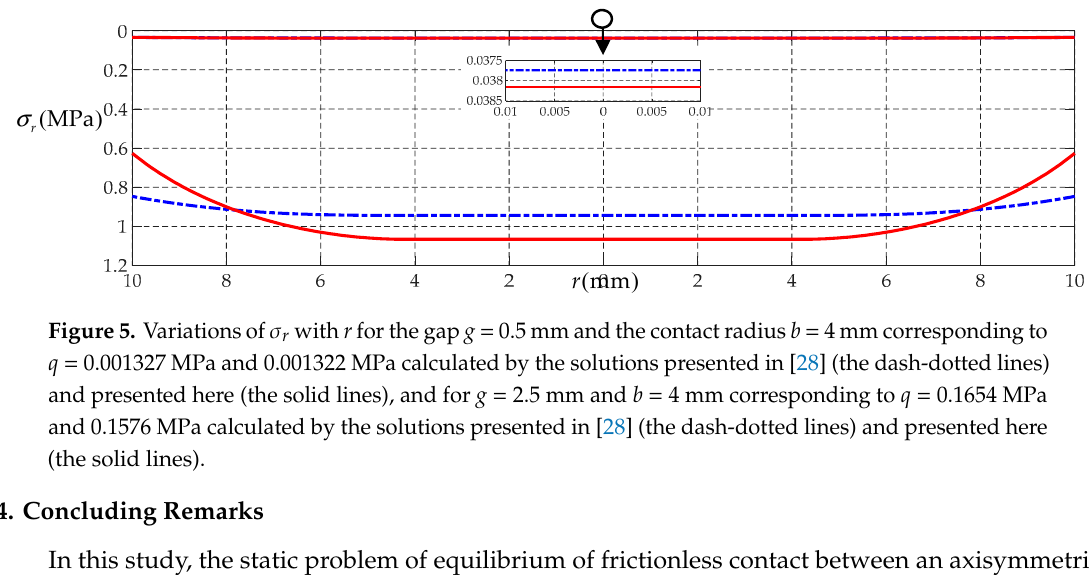
Figure 4. Variations of w with r for the gap g = 0.5 mm and the contact radius b = 4 mm corresponding to q = 0.001327 MPa and 0.001322 MPa calculated by the solutions presented in [28] (the dash-dotted lines) and presented here (the solid lines), and for g = 2.5 mm and b = 4 mm corresponding to q = 0.1654 MPa and 0.1576 MPa calculated by the solutions presented in [28] (the dash-dotted lines) and presented here (the solid lines).